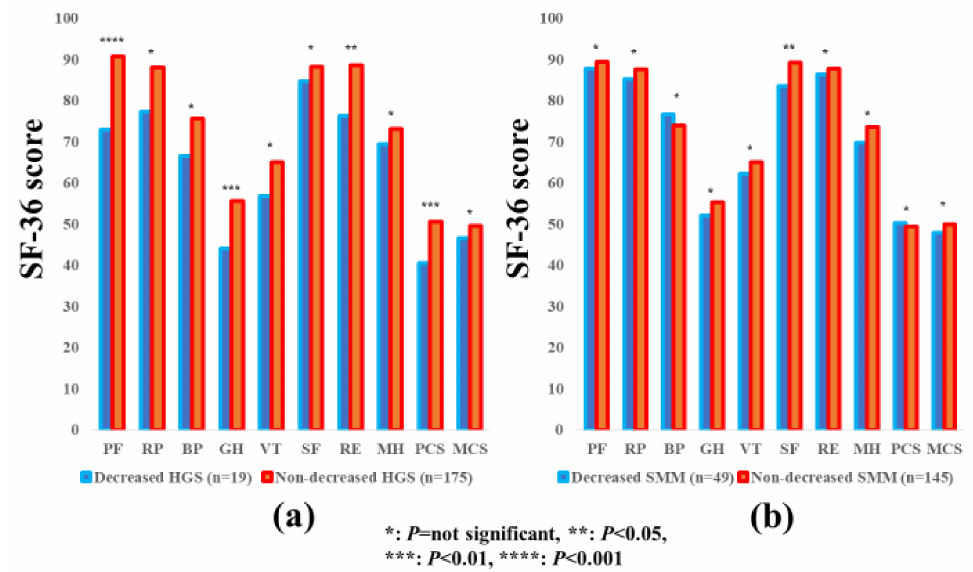
Figure 7. The SF-36 scores across 10 items in the decreased and non-decreased HGS groups ( a ), and the decreased and non-decreased SMM groups ( b ) in patients aged <65 years ( n = 194). The average scores in each item of the SF-36 were